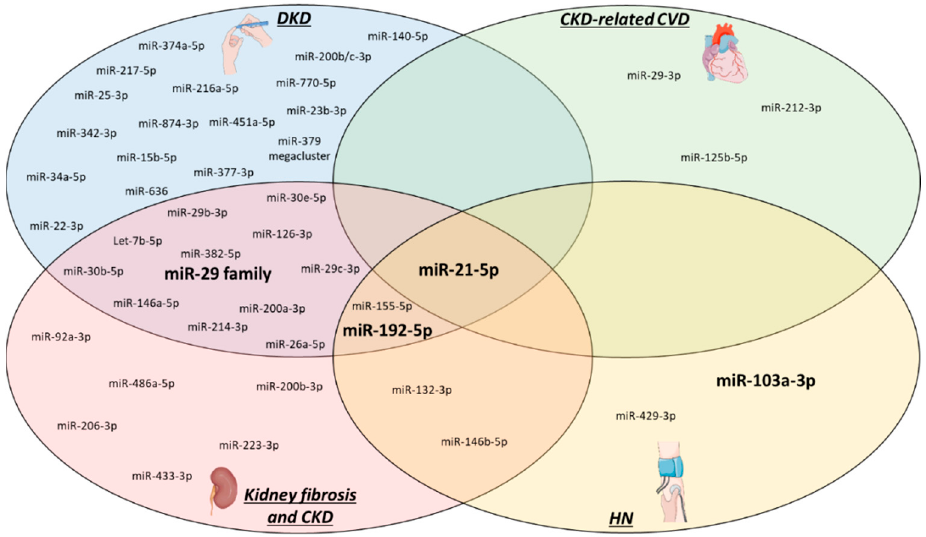
Figure 2. CKD-related microRNAs. All miRs that have until now been studied in CKD (ex-vivo or in-vivo models only) are depicted based on their relation to the specific pathologies. From all of these, the four relevant miRs that are highlighted in this review are visualized in bold. HN: hypertensive nephropathy, DKD: diabetic kidney disease, CVD: cardiovascular disease, CKD: chronic kidney disease.